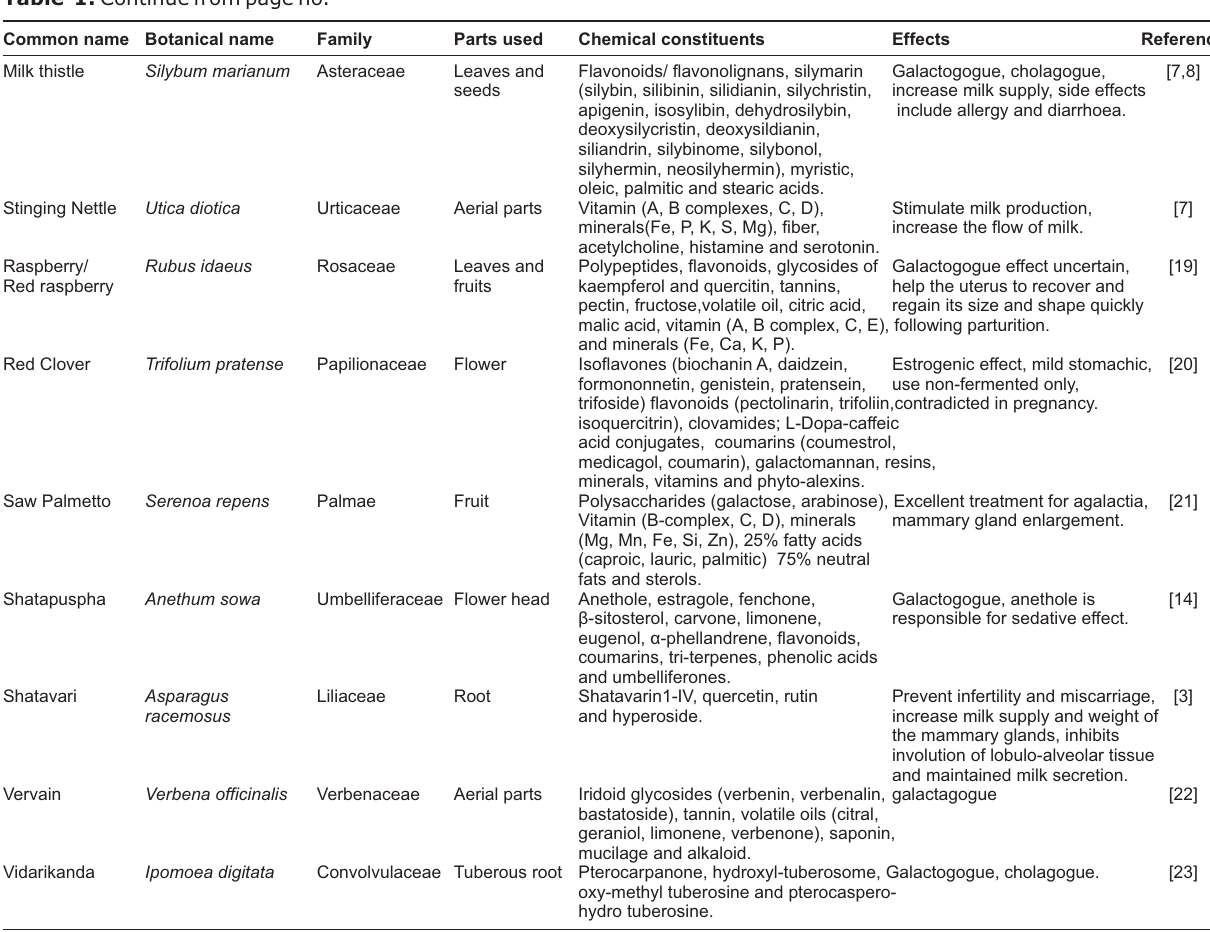
Table-1: Continue from page no. Common name Botanical